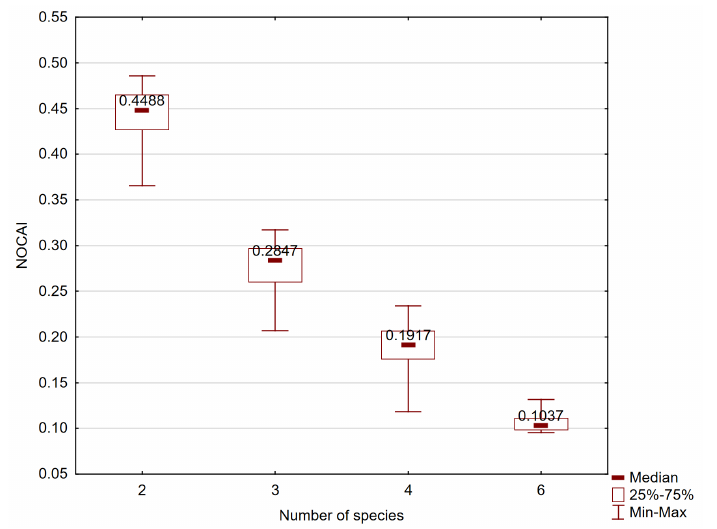
Figure 4. Relationship between NOCAI and the number of discriminated species in the reviewed studies.